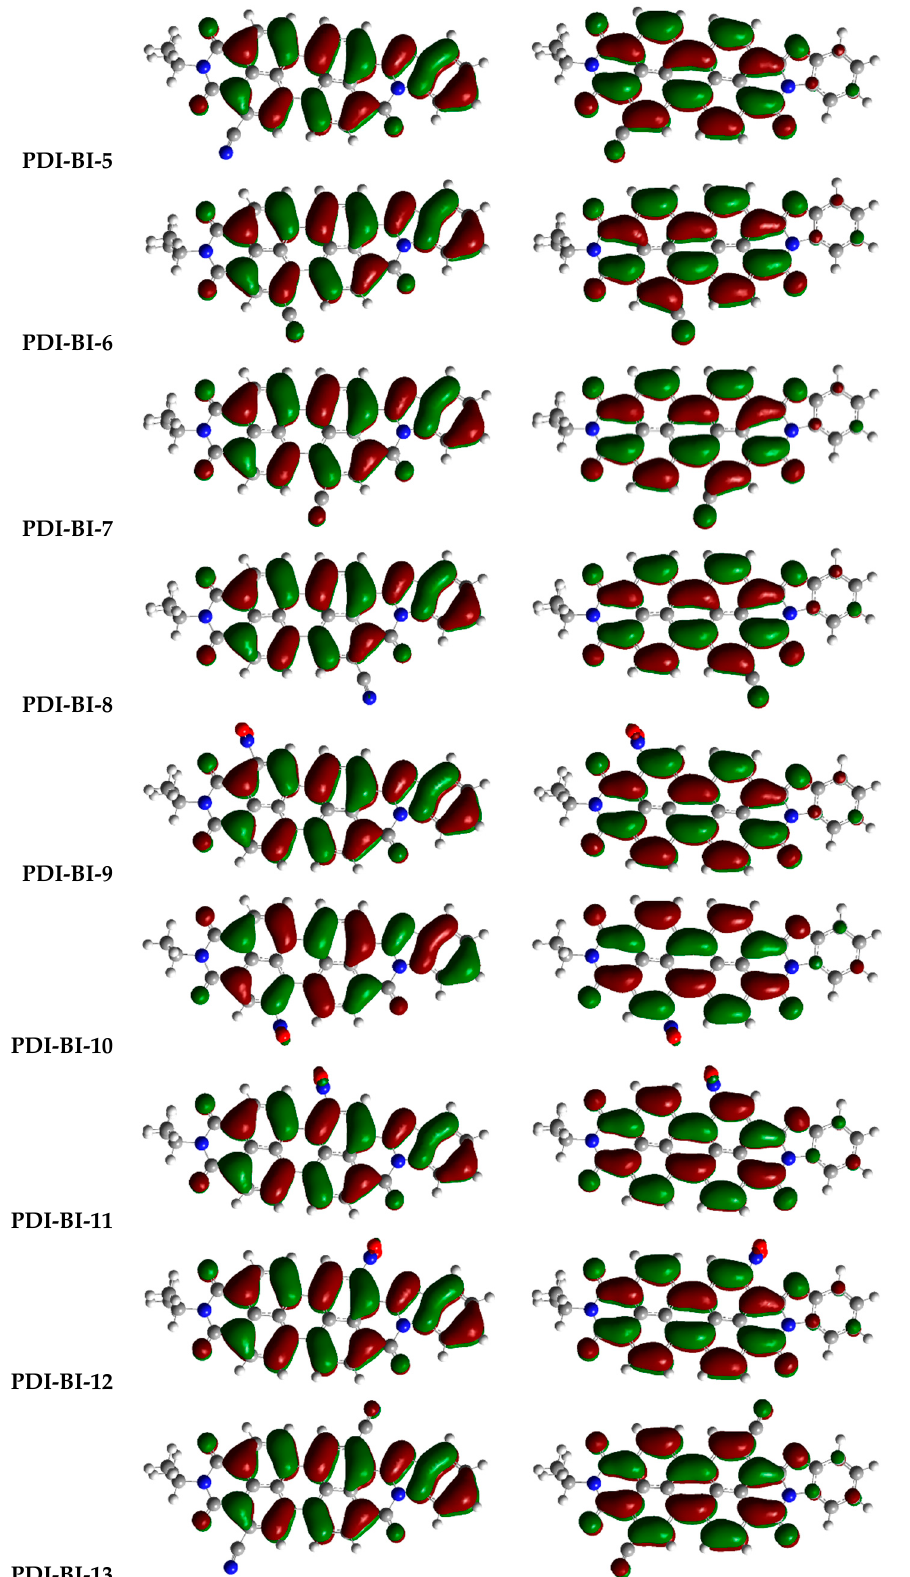
Figure 2. Cont. Figure 2.